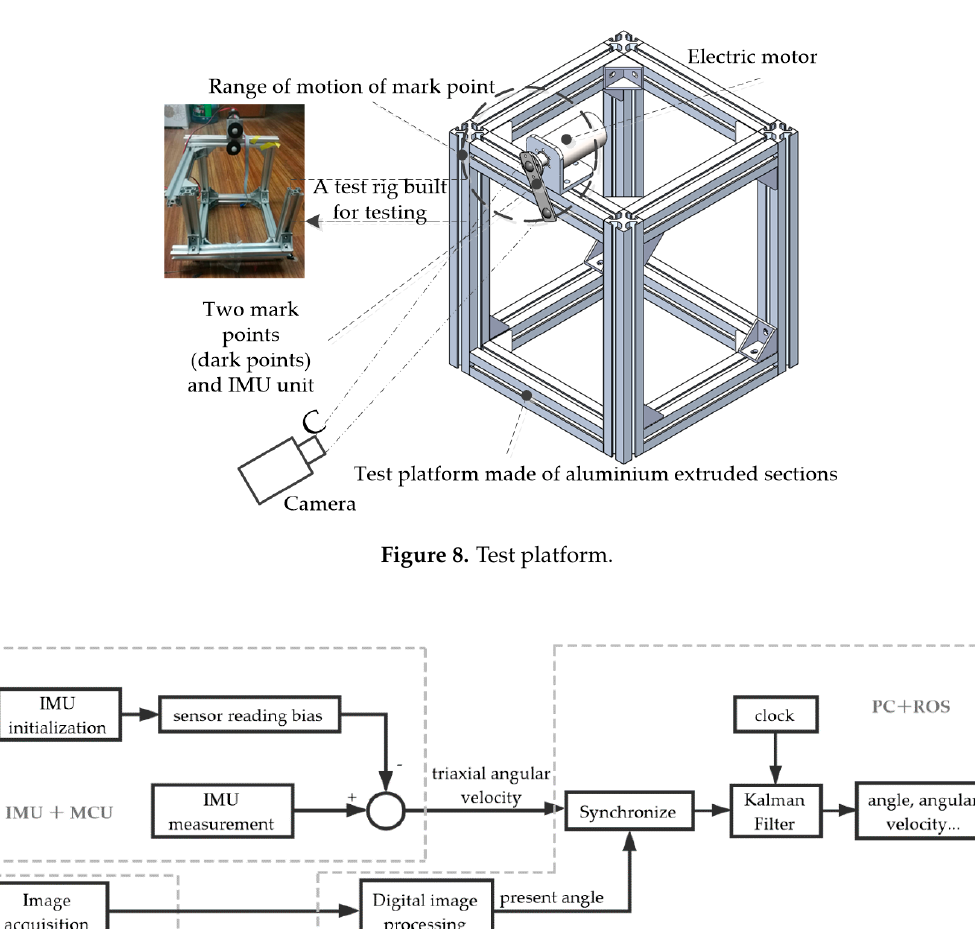
Figure 9. Data flow diagram.